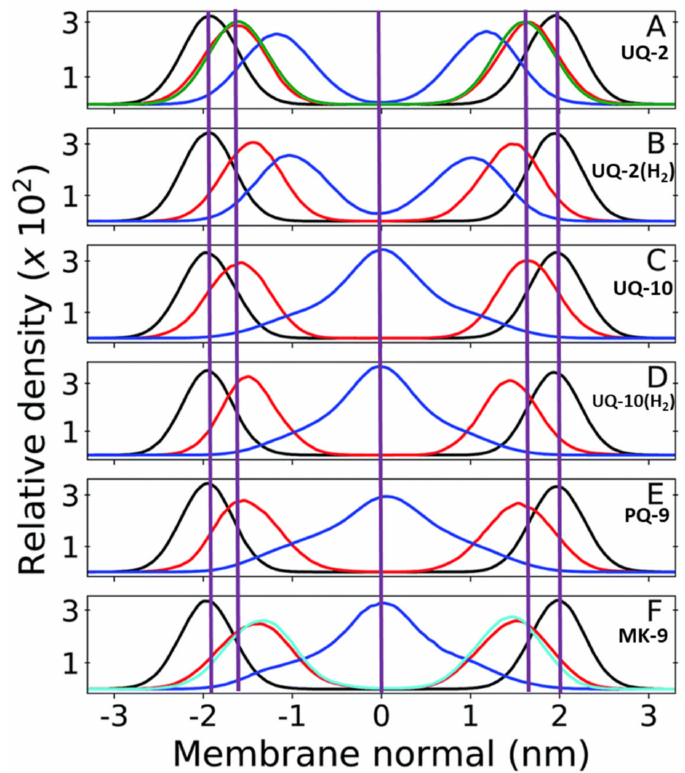
Figure 12. Relative mass density of multi-component bilayers with different lipoquinone derivatives (different lengths, degrees of unsaturation, and headgroups). The phosphate groups of DPLC and DLPE are shown in black, quinone headgroup in red, and sidechain in blue. Vertical purple lines are shown to emphasize the changes in position of the headgroup and the end of the sidechain relative to UQ-2 and the membrane center line. ( A ) UQ-2. Green curve shows the density of the DPLC and DPLE glycerol group; ( B ) ubiquinol-2 (UQH 2 -2); ( C ) UQ-10. ( D ) ubiquinol-10 (UQH 2 -10).; ( E ) PQ-9; and ( F ) MK-9. The cyan line shows the first 6 carbons of the naphthoquinone ring. The red line is the full ring system. The purple zero line corresponds to the center of the bilayer. Adapted with permission from Ref. [40]. Copyright 2022, Royal Society of Chemistry. The figure was modified to include the purple, vertical lines and lipoquinone derivative